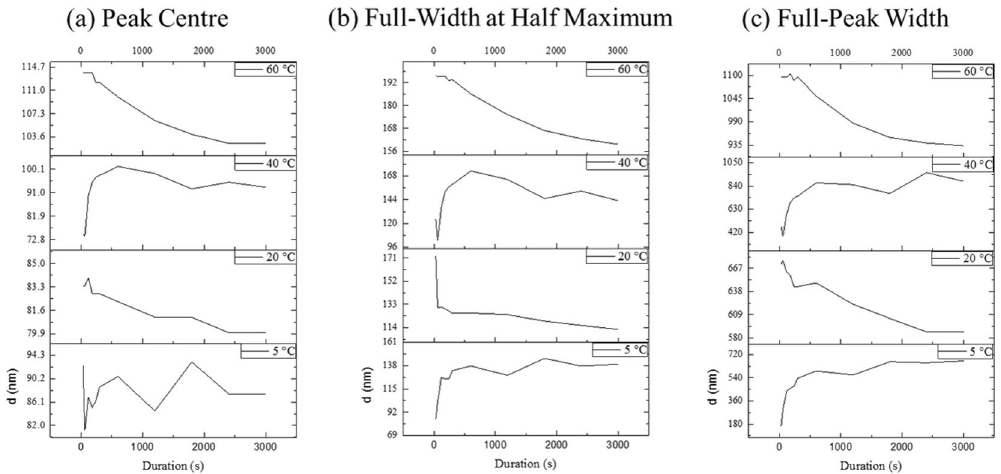
Figure 4. Peak shifting with duration increasing. ( a ) Peak centre ( b ) Full width at half maximum of the peak ( c ) Full-peak width of the peak. Dealloyed of Cu-Zn with a 1 M NaOH solution and for 3000 s; details on the peak fittings are provided in the supplementary